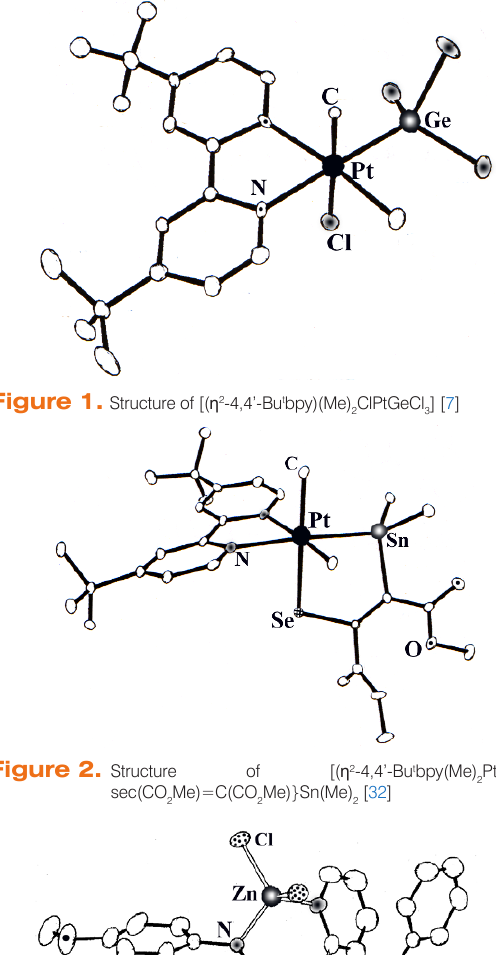
Figure 2. Structure